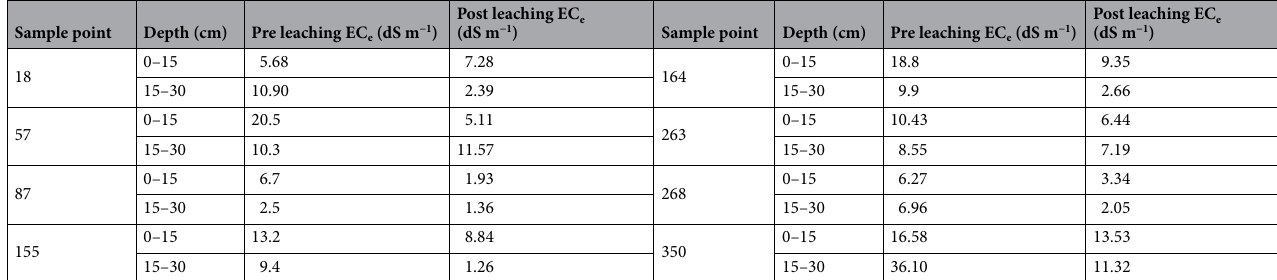
Table 1. Soil salinity at the sampling points for pre and post leaching for fairway 16. Sites 110 and 217 could not be analyzed (no-pre leaching samples), due to insufficient residual soil volumes (for